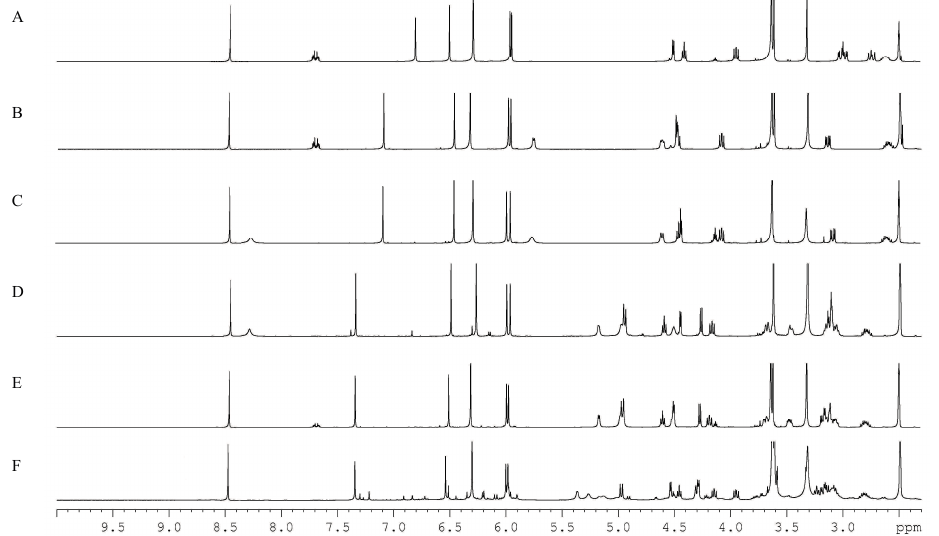
Figure 3. 1 H-NMR spectra of six aryltetralin lactone lignans (500 MHz, DMSO- d 6 ): ( A ) DPD; ( B ) PD; ( C ) DMPD; ( D ) DMPDG; ( E ) PDG; ( F ) PDAG. 1,4-Dinitrobenzene (IS) signal was a singlet at δ